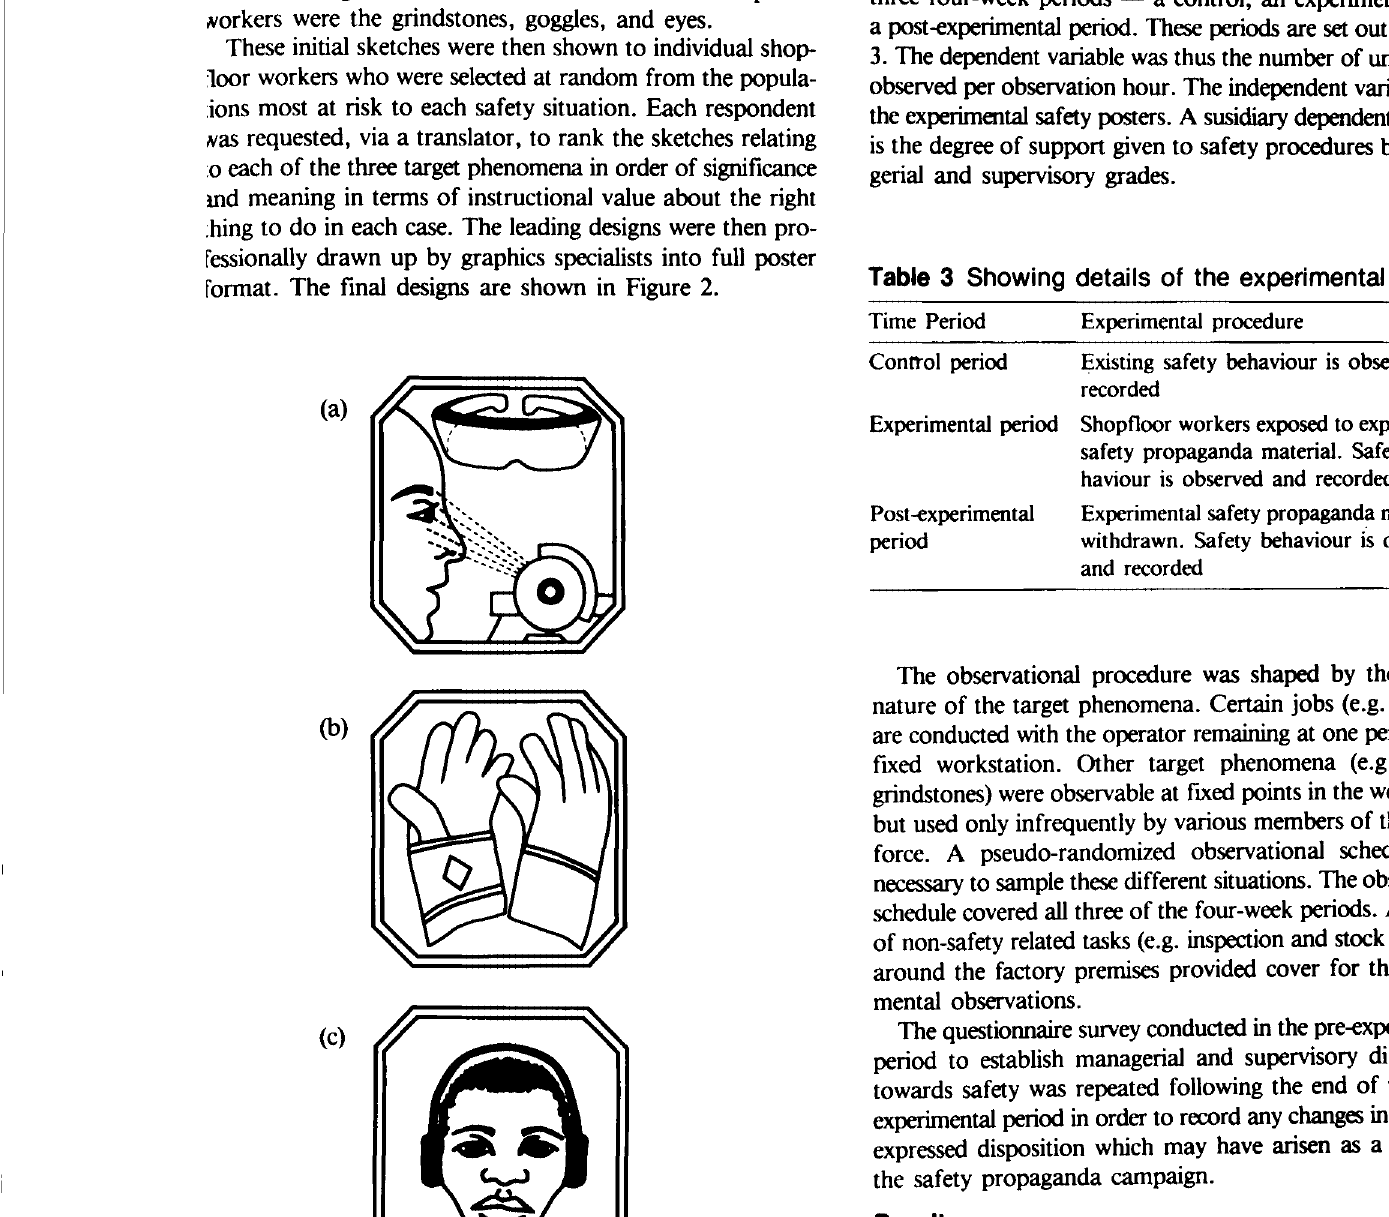
Figure 2 Showing the final designs for experimental safety posters: (a) The need to wear protective goggles, (b) The need to wear protective gloves, (c) The need to wear protective ear muffs